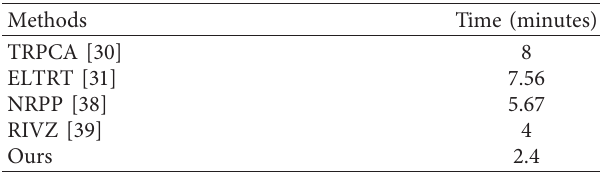
Figure 5: 1 st column, corrupted video face image; 2 nd column, the low-rank component by [31]; 3 rd column, the low-rank component by [30]; 4 th column, the low-rank component by [38]; 5 th column, the low-rank component by [39]; 6 th column, the low-rank component by the proposed method. Table 2: Time complexity of the proposed